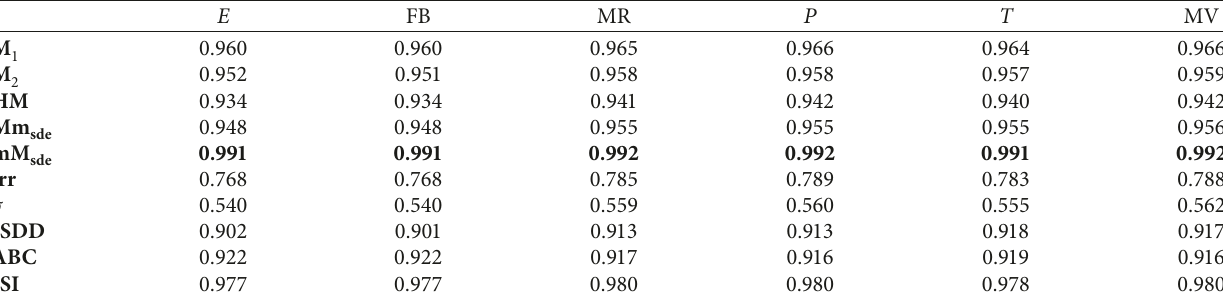
Table 4: The correlation coefficient ( R ) obtained by linear regression model between topological indices and physicochemical properties of various drugs used in treatment of COVID-19.